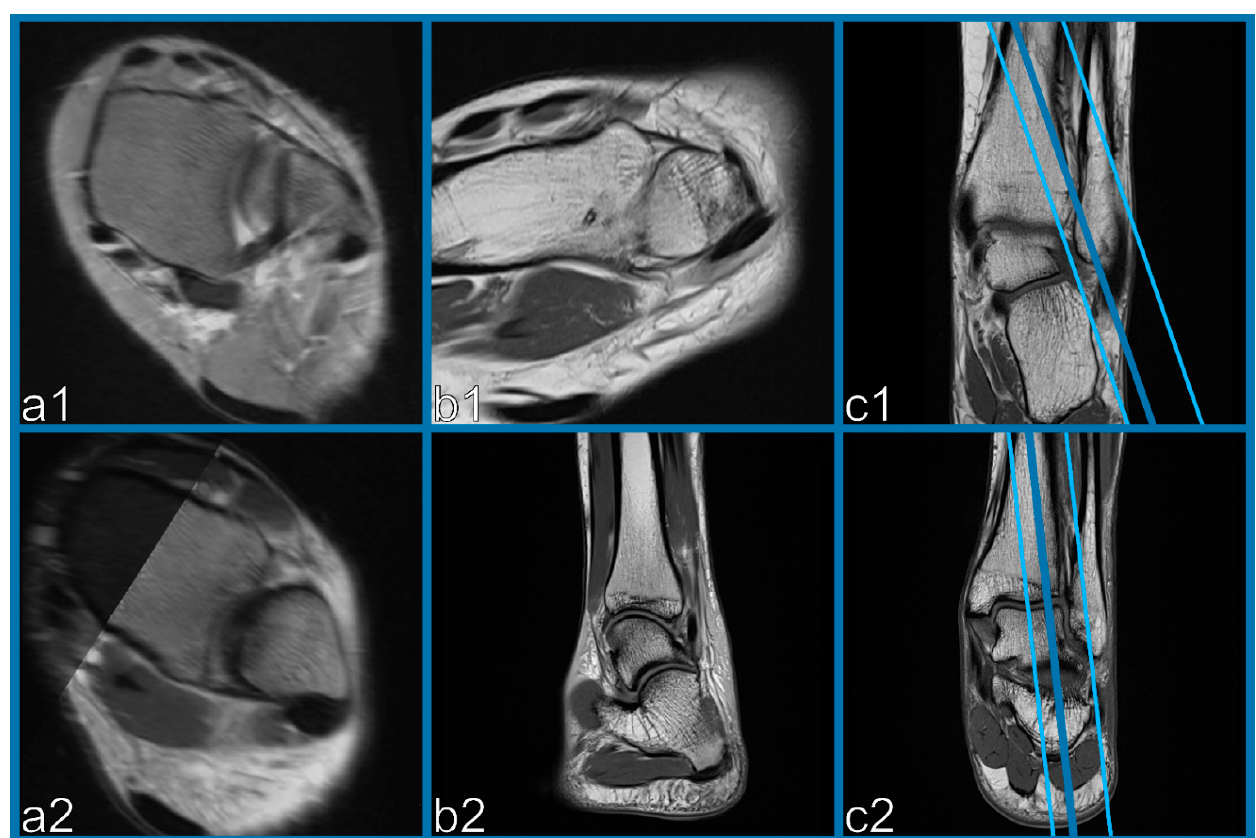
Figure 3. Example of two incorrectly scanned oblique sequences ( b1,b2 ) with alignment angles greater than 60° (blue lines in c1,c2 ) with regards to the tibial plafond resulting in diagnostically insufficiently scanned oblique images ( b1 , b2 ). OFR images with correct angulation demonstrating one intact ( a1 ) and one ruptured AITFL ( a2 ).